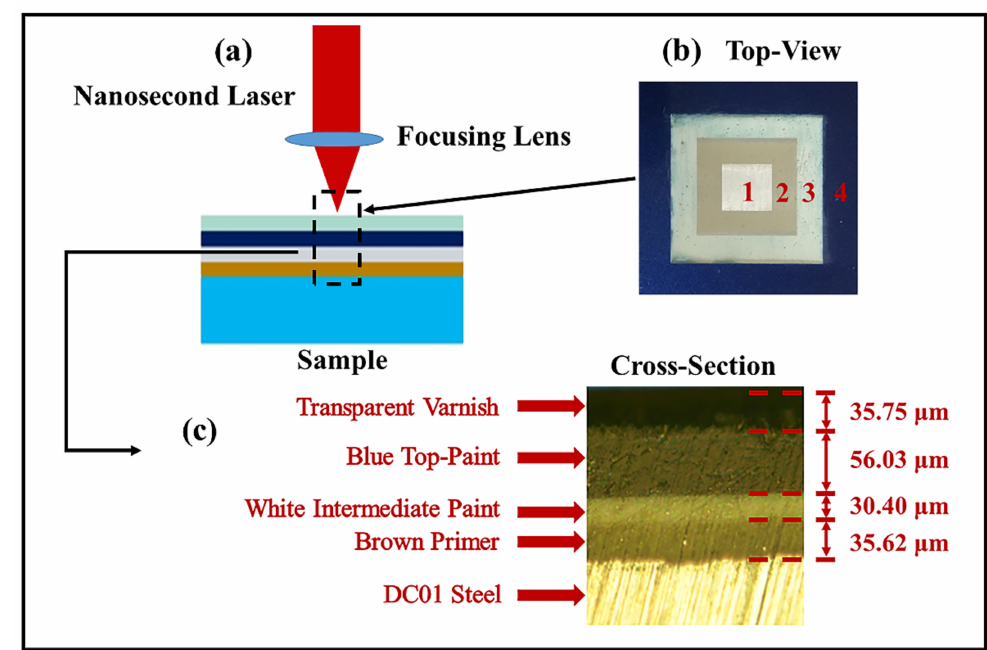
Figure 1. ( a ) Sample used for laser paint removal. ( b ) Top view of the sample. ( c ) Optical micrograph of cross-section of the